Question: What style of plot is this figure drawn as?
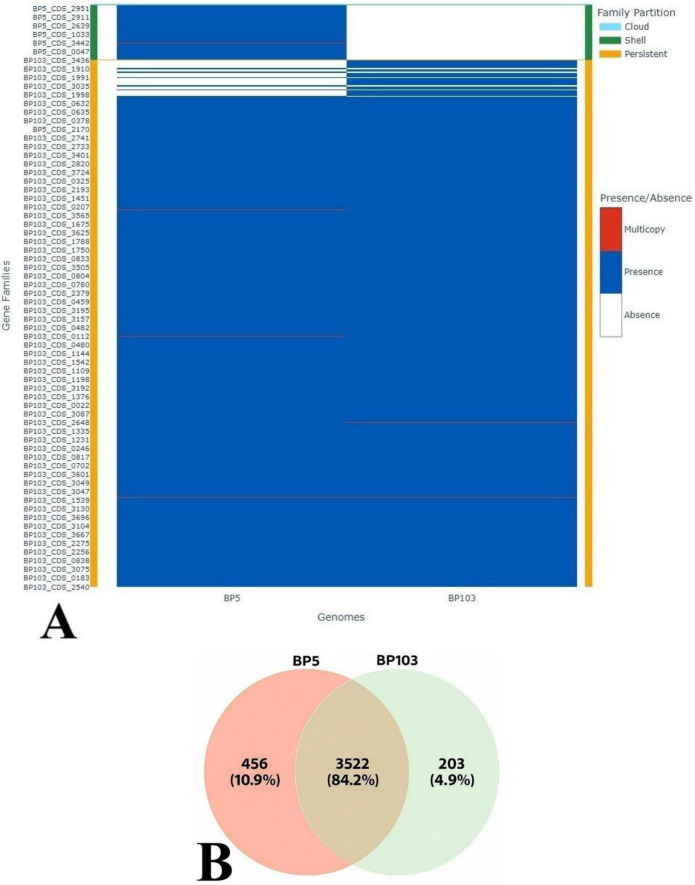
Answer: heatmap